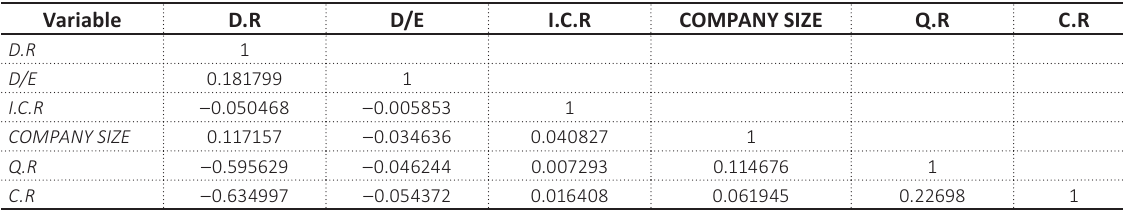
Table 2. Matrix of cross-correlations between independent variables